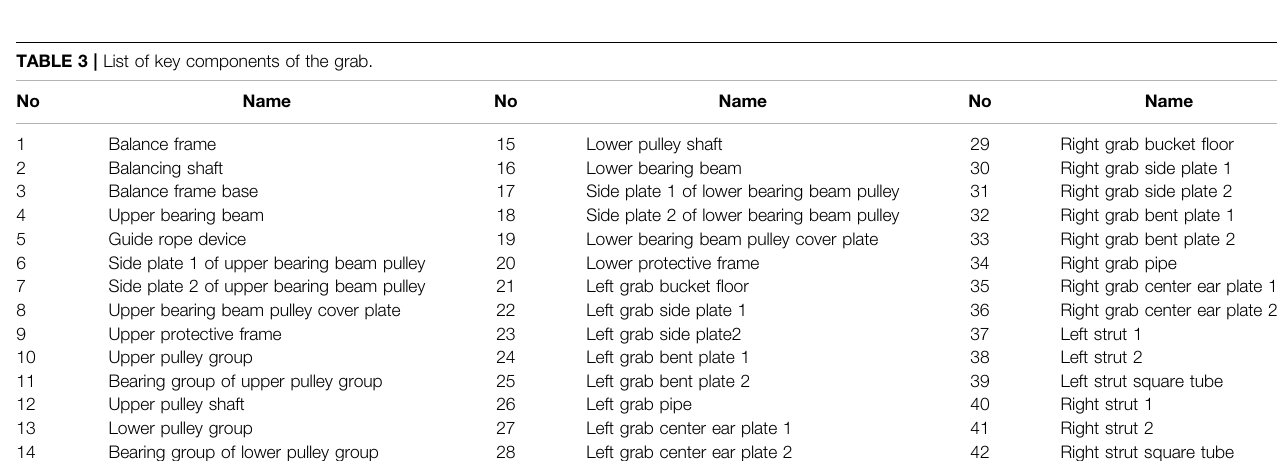
FIGURE 7 | Structure of the grab and its components explosion.